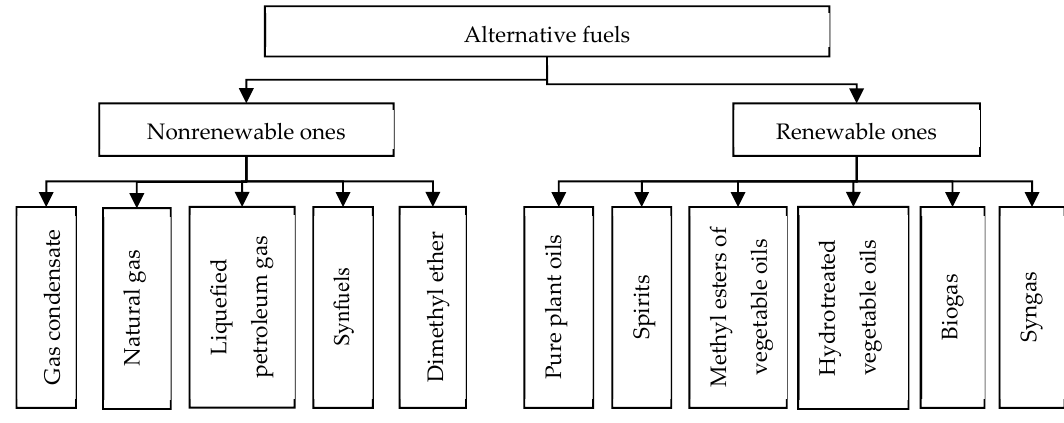
Figure 1. Classification of alternative vehicle fuels.